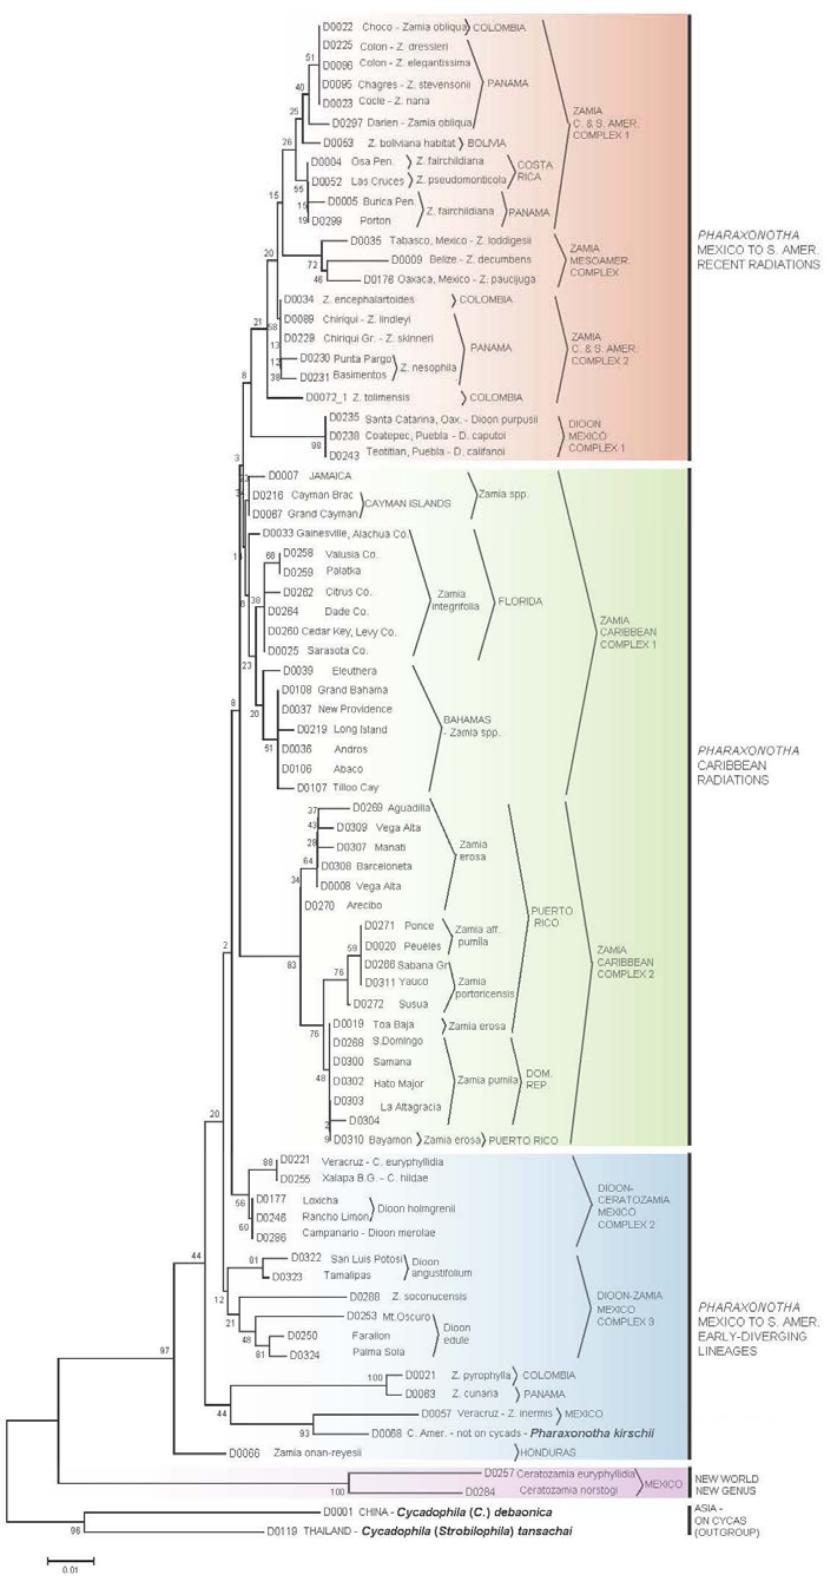
Figure A2. Phylogenetic tree for the Erotylidae: Pharaxonothinae on the cycads of the New World based on neighbor joining (NJ) analysis of 16S rRNA gene sequences; scale bar indicates base pair substitutions per nucleotide position; numbers on branches are bootstrap values.